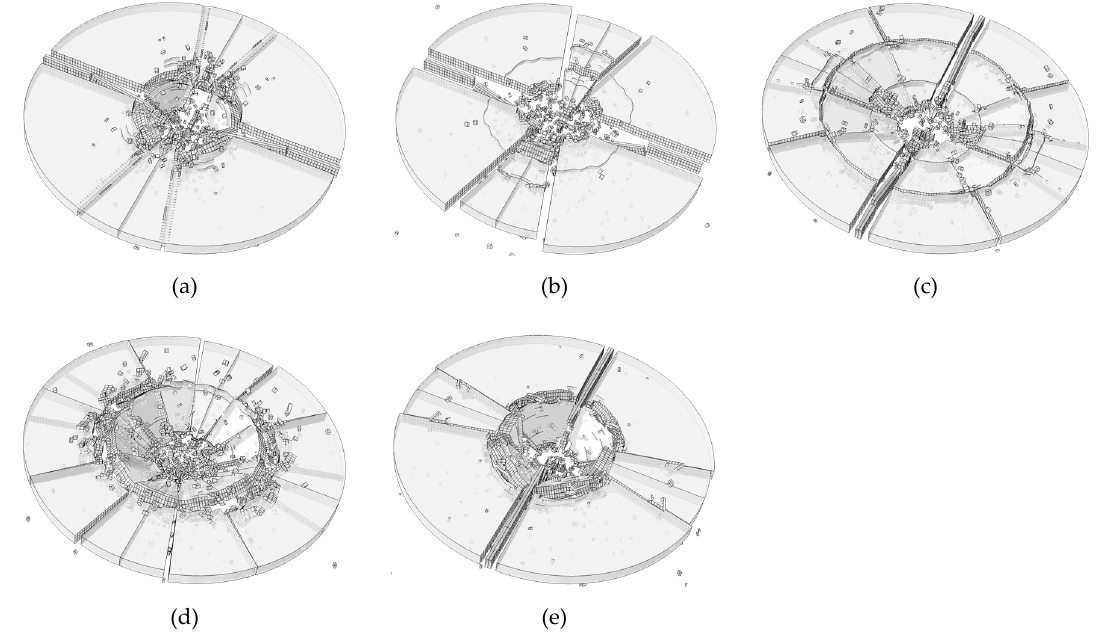
Figure 11. Effect of C on the results ( a ) C = 0.00; ( b ) C = 0.01; ( c ) C = 0.02; ( d ) C = 0.03; ( e ) C = 0.04.